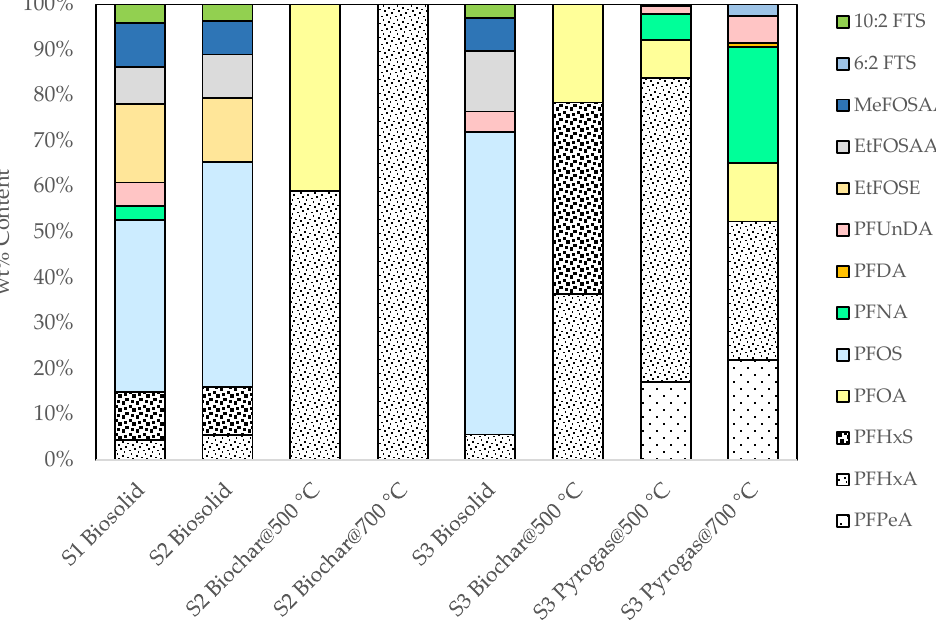
Figure 2. PFAS components (wt%) detected in biosolid, biochar, and pyrogas at 500 and 700 ◦ C. Molecular structure color codes: Carbon: gray; Nitrogen: blue; Hydrogen: white; Oxygen: red; Fluorine: green; Sulfur: yellow.